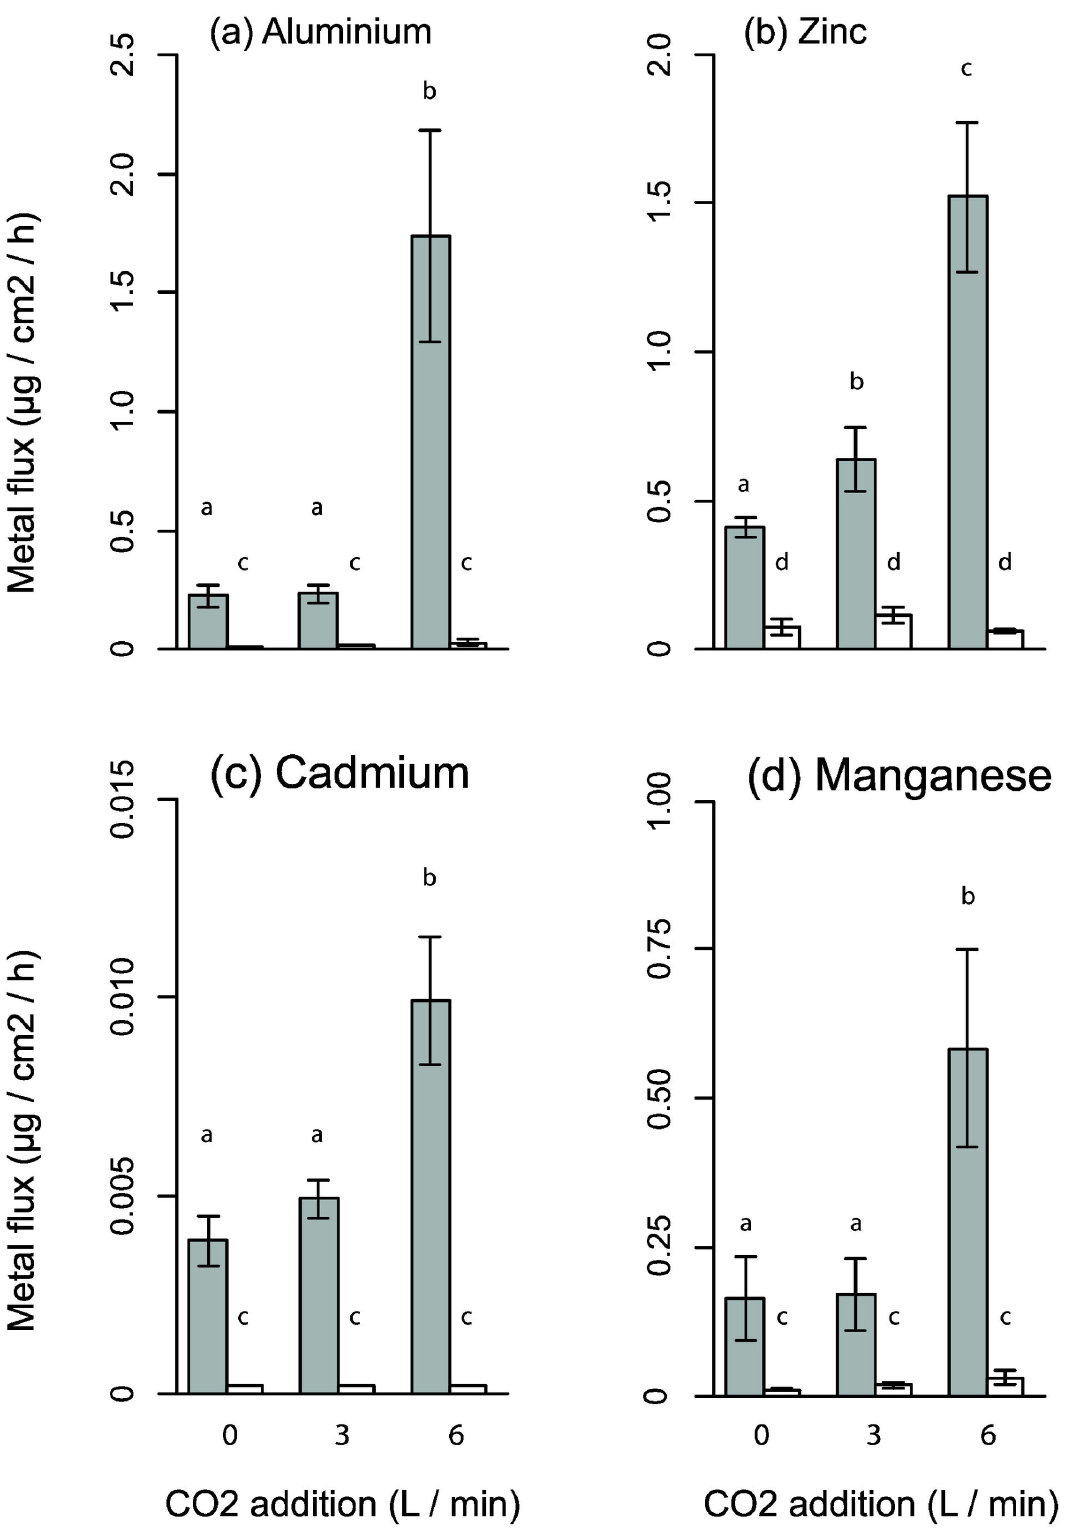
Figure 2. Metal flux from Ash Dam Water (grey bars) and Dechlorinated Town Water (white bars) under different CO amendment regimes. Bars sharing a common letter do not differ significantly (Tukey HSD P > 0.05). doi: 10.1371/journal.pone.0081631.g002 PLOS ONE |